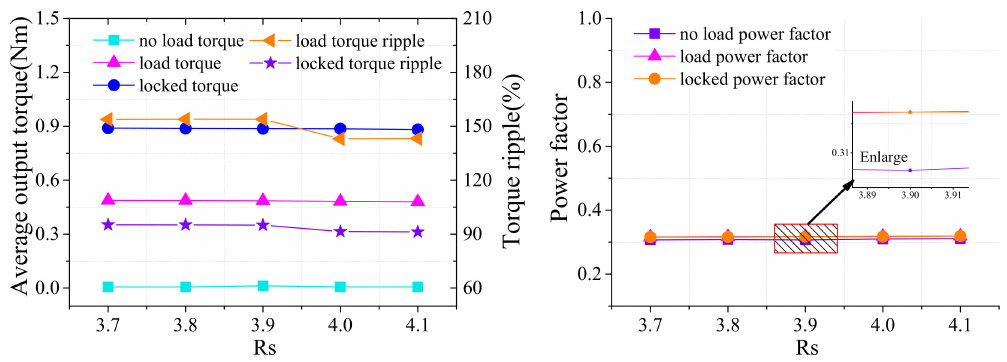
Figure 10. Influence of slot radius on average output torque and power factor at no load, load, and